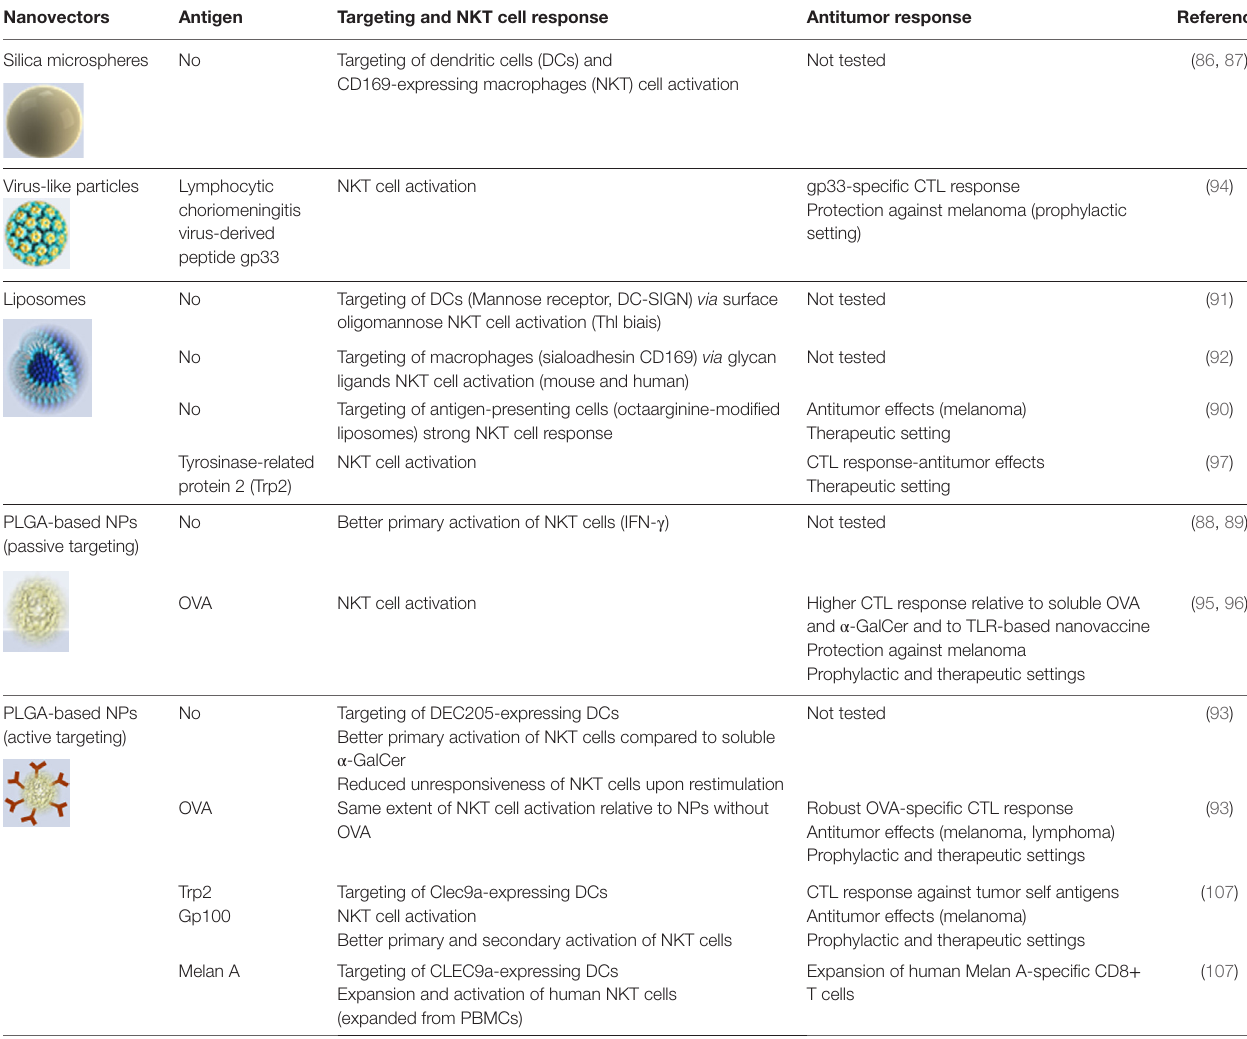
TAbLe 2 | Utilization of α -GalCer-encapsulated nanovectors to promote NKT cell activation and antitumor